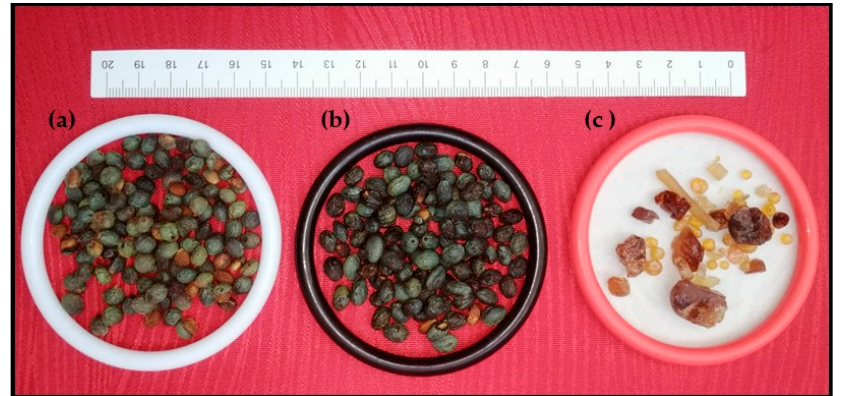
Figure 4. Atlas pistachio fruits from two countries and two different subspecies ( a ≠ b ) and resin: ( a ) Pistacia atlantica fruits from Iran. ( b ) Pistacia atlantica subsp. atlantica fruits from the region of El bayadh, Algeria; ( c ) Pistacia atlantica subsp. atlantica resin from the region of El bayadh, Algeria. Personal photo taken by the first author.